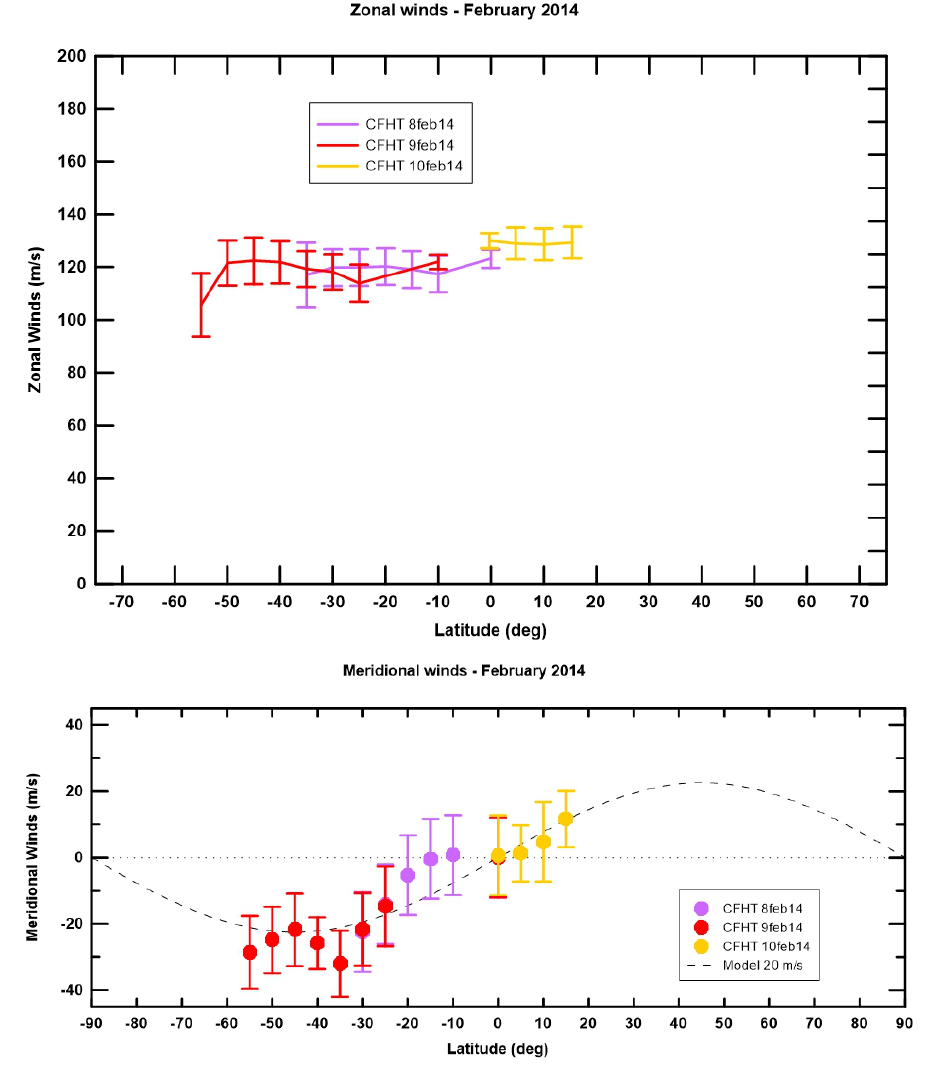
Figure 8. (Upper panel) Mean zonal wind latitudinal profile retrieved with Doppler velocime- try techniques using high-resolution spectra from CFHT/ESPaDOnS ground-based observations. The segments in different colours are the profile’s contribution from each day of observations (see fig- ure legend). (Lower panel) Here, we present the mean meridional wind latitudinal profile based on the same dataset as was described for the left panel’s case. Positive velocities mean a poleward merid- ional wind moving from the equator to the north; negative velocities mean a southern hemisphere meridional motion from equator towards the